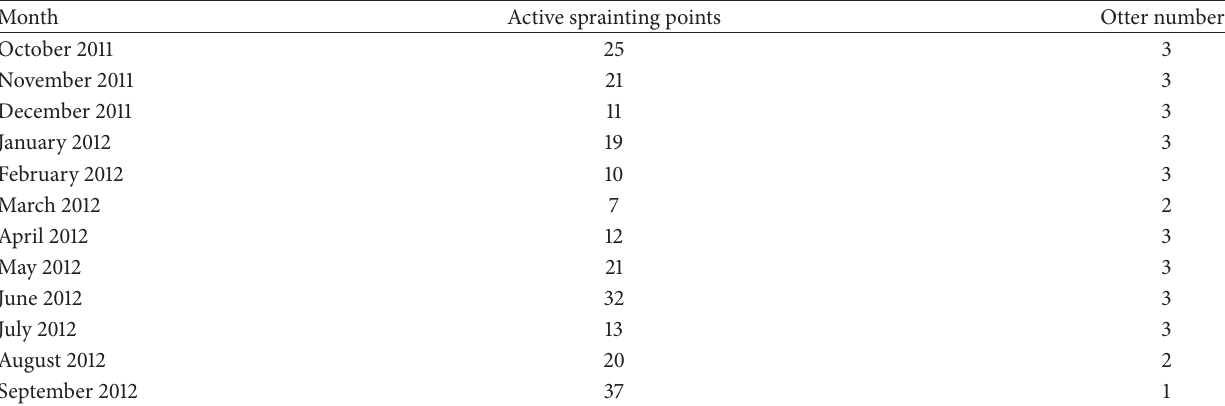
Table 4: Active sprainting points on